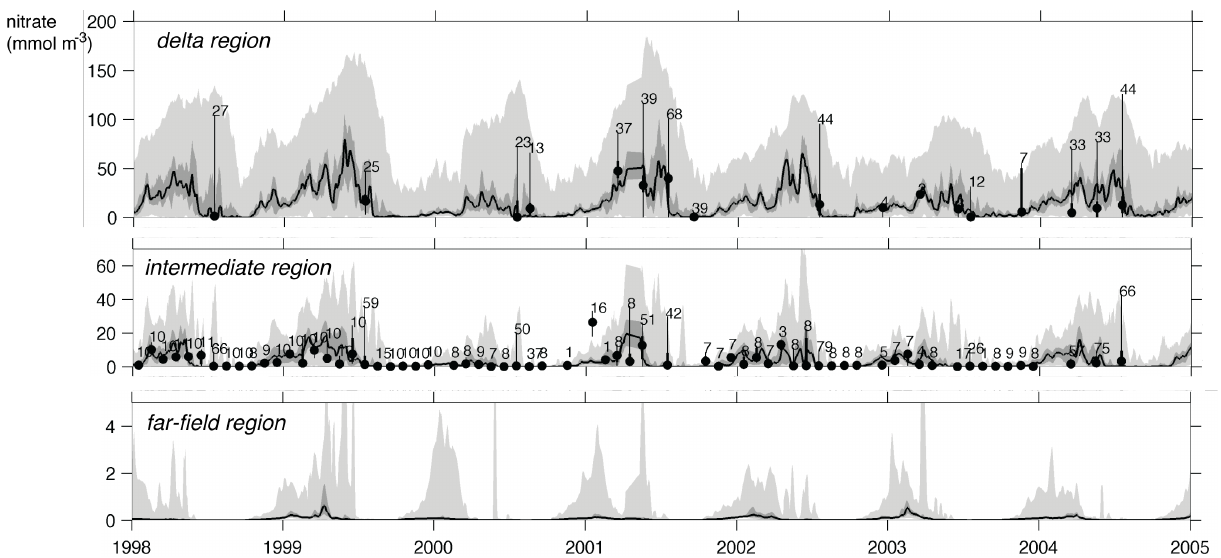
Fig. 5. Median (thick line), range between 25th and 75th percentiles (dark gray) and range between minimum and maximum simulated surface nitrate in the delta, intermediate and far-field regions (defined in Fig. 1) and corresponding median (dots), range between 25th and 75th percentiles (thick vertical lines) and range between minimum and maximum values (thin vertical lines) of monthly binned observations. The number of observations in each monthly bin is shown near each maximum value.